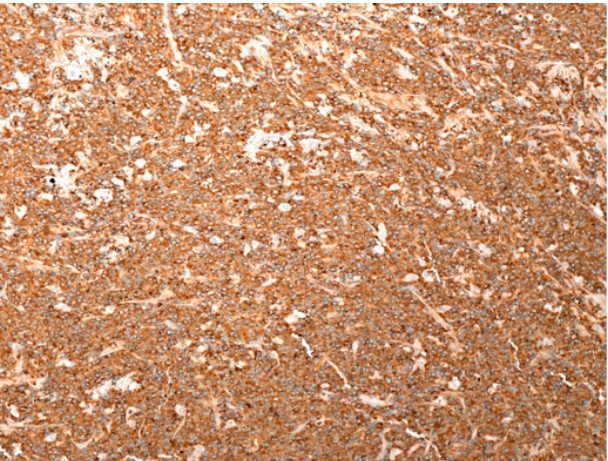
Figure 8. Cutaneous localization of MM: kappa immunoglobulin light chain restriction of the infiltrate (immunostaining, magnification 100×; original image from Prof. S.A.). B- (CD20) and T-cell markers (CD3) were negative, as well as human herpes virus 8 (HHV8). The proliferative fraction was high (ki67: 90%). EBV encoded ribonucleic acid (EBER) in situ hybridization was negative. A diagnosis of secondary cutaneous involvement by MM with polymorphic morphology was